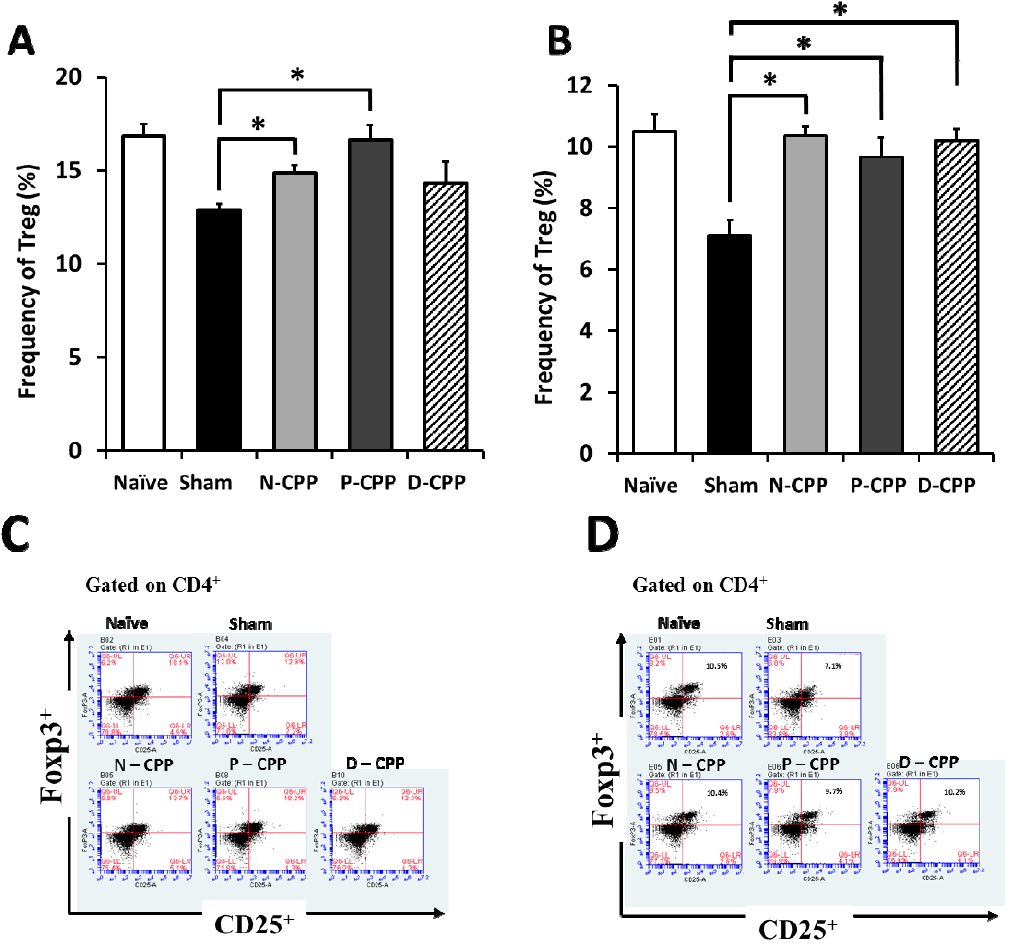
Figure 5. Effects of oral feeding with differently phosphorylated CPP-III on Treg cell population. Percentages of Treg cell populations in cultured SP ( A ) and payer’s patch (PP) ( B ). Representative FACS staining for SP ( C ) and from PP ( D ). Cells harvested from OVA-sensitized mice were determined by flow cytometry without stimulation with OVA. Data represent the mean ± SE of individual mice in the group. * p < 0.05 and dots represent cell proliferation.